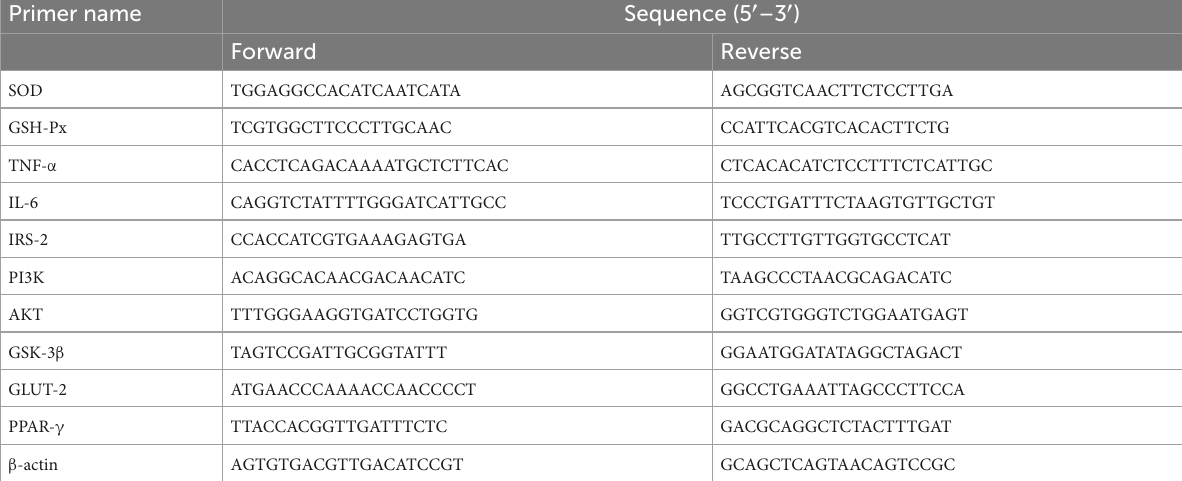
TABLE 1 Sequences of oligonucleotide primers used in qRT-PCR analysis.